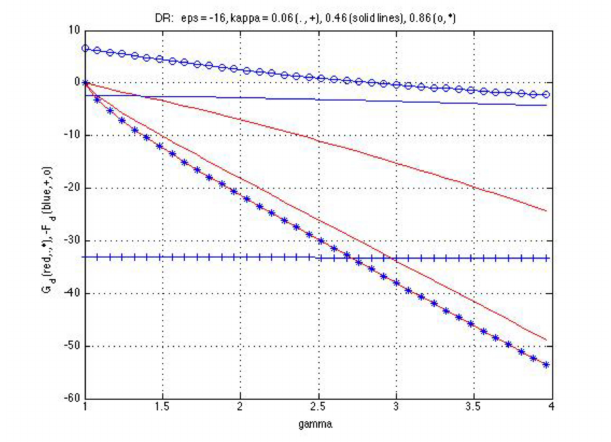
Figure 5: Plots of F d = F d ( γ ) (blue) and G d = G d ( γ ) (red) of DE (9) showing the evolution of the fundamental DR surface mode for (cid:15) = − 16 at κ = 0 . 06 (upper red curve, +), 0.46 (middle curves), and 0.86 (o,